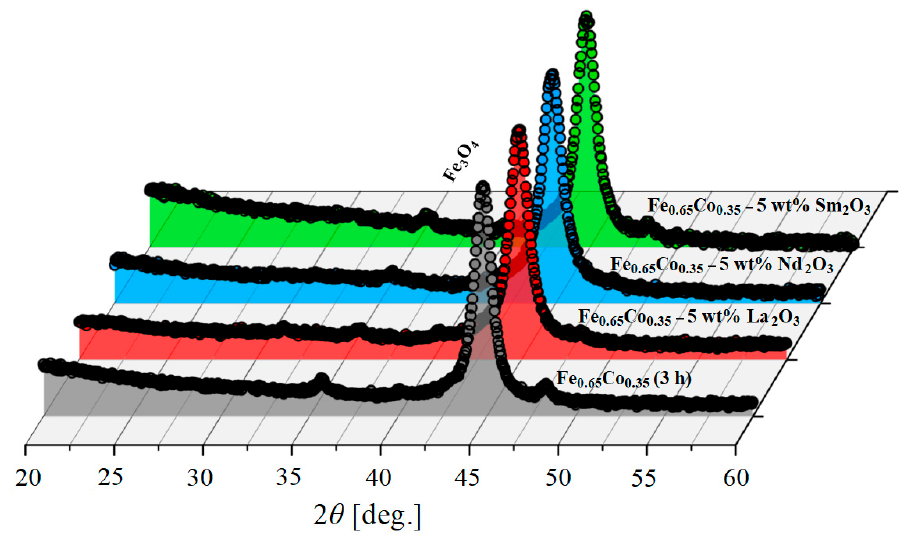
Figure 4. X-ray diffraction (XRD) patterns of Fe 0.65 Co 0.35 (3 h) alloy and (Fe 0.65 Co 0.35 ) 0.95 ( RE 2 O 3 ) 0.05 samples with RE = La, Nd, and Sm. The Y-axis was square-rooted to magnify small peaks. Figure4showstheXRDspectrumsoftheFe 0.65 Co 0.35 (3h)alloyand(Fe 0.65 Co 0.35 ) 0.95 ( RE 2 O 3 ) 0.05 samples with RE = La, Nd, and Sm. The characteristic peaks of Co, La 2 O 3 , Nd 2 O 3 ,